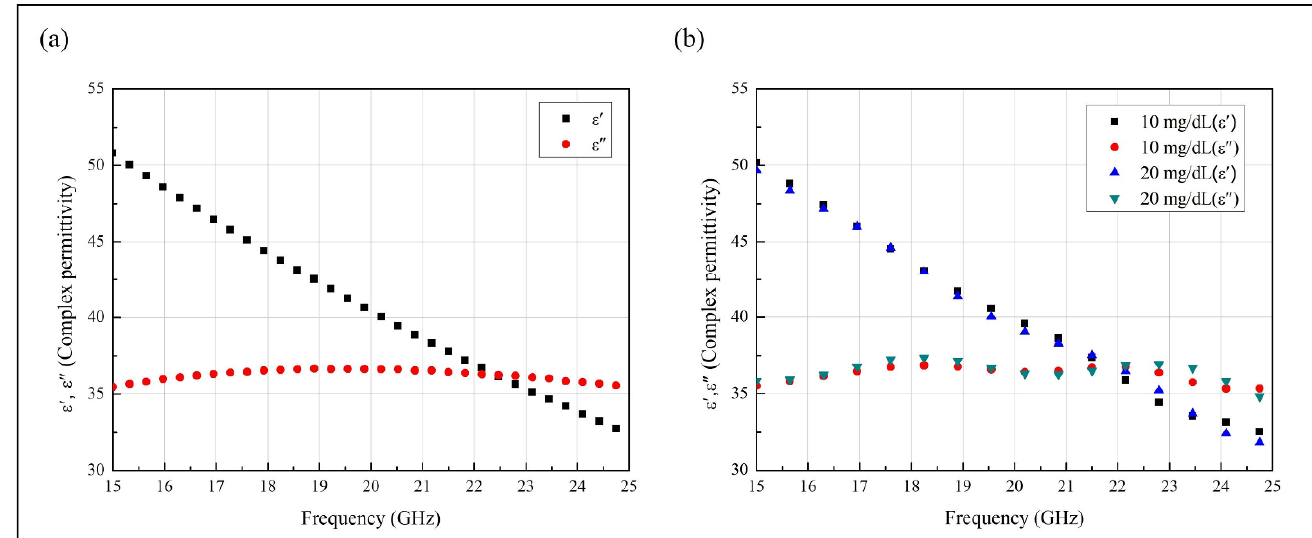
Figure 1. Complex relative permittivity ε (cid:4593) and ε″ of ( a ) deionized water and ( b ) 10 and 20 mg/dL glucose, all measured at 27.8 °C.